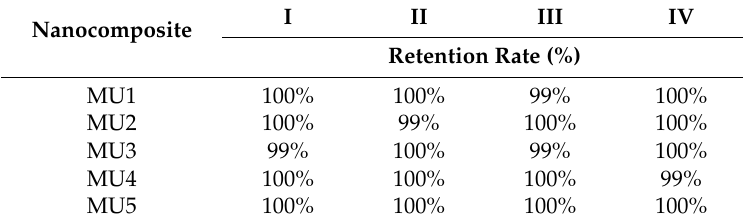
Table 10. Permanent shape retention rate (R r ) during the shape recovery process.